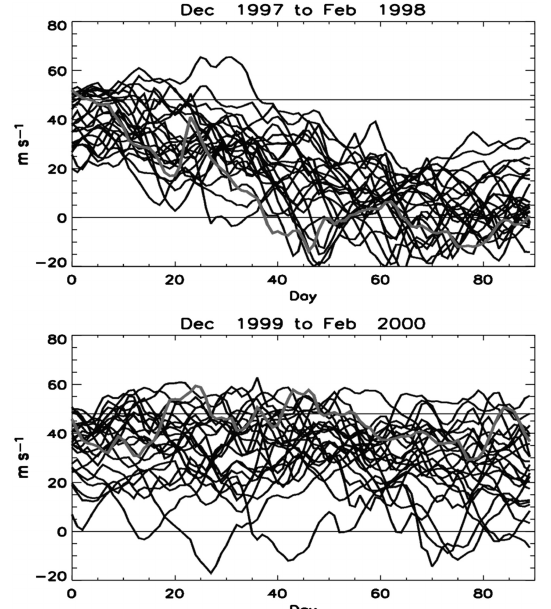
Figure 16. Ensemble forecast evolution of zonal wind in the strato- sphere. Zonal mean winds are shown (10hPa, 60 ◦ N) in two dif- ferent winters, with 24 ensemble members per winter. The hori- zontal lines show the threshold for SSW (0ms − 1 ) events and SPV (48ms − 1 ) events. The two winters shown exhibit quite different predicted probability of a SSW or SPV event, indicating the poten- tial for forecasting the risk of these events well beyond the deter- ministic range of a few weeks. Adapted from Fig. 1 of Scaife et al. (2016). ©Crown Copyright Met Office, https://creativecommons. org/licenses/by/4.0/ (last access: 1 November 2022).